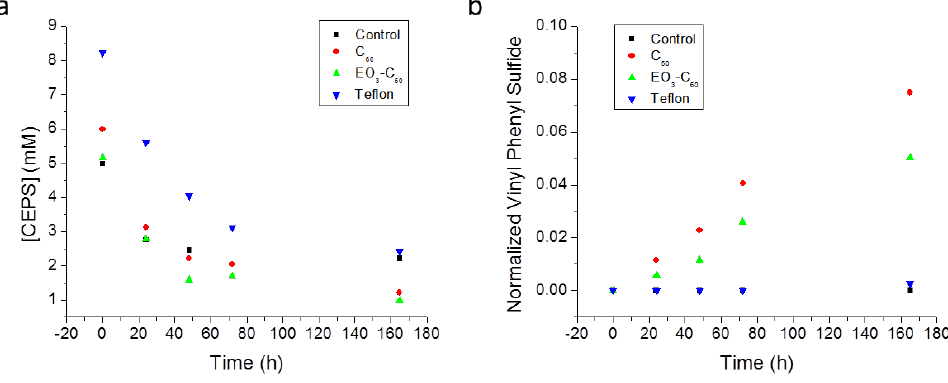
Figure 11. Concentration of CEPS recovered from samples over a 165 h residence ( a ) and normalized vinyl phenyl sulfoxide degradation product ( b ).